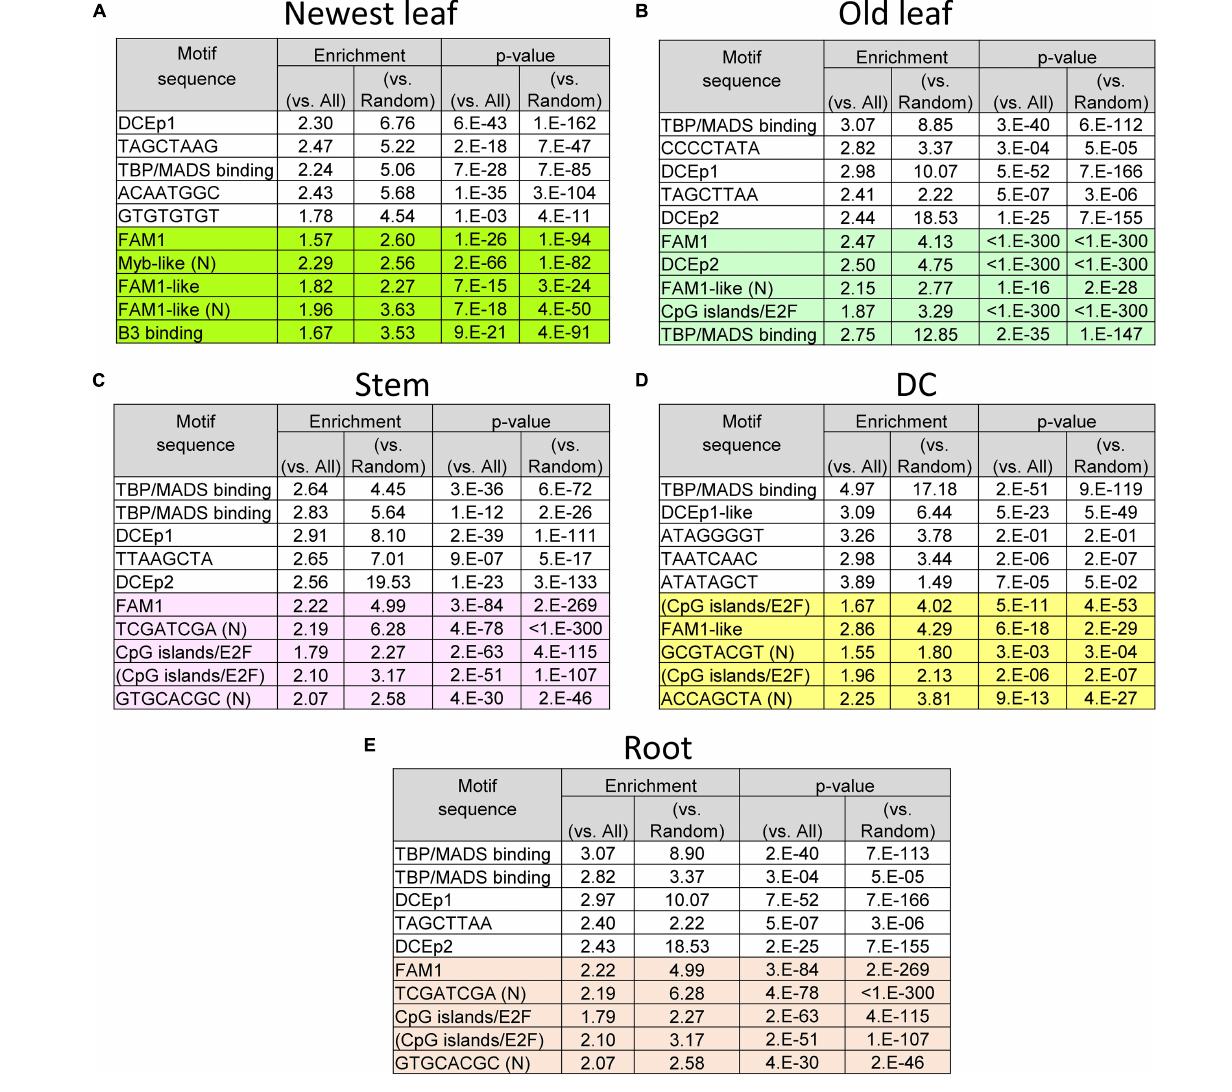
FIGURE 6 | List of extracted CRE candidates from each tissue: (A) Newest leaf, (B) Old leaf, (C) Stem, (D) DC and (E) Root. DC means discrimination center or junction notes between root and shoot. White background cells show CRE candidates from –50 to +150 window, colored background shows CRE candidates from 500 bp upstream of TSS. (N) indicates CRE candidates that were not reported before. CpG islands/E2F (CGCGCGCA) motif has variants CGCGCGCG, CGCGCGTA, and CGCGCGTG. They were annotated as “(CpG islands/E2F).” Enrichment of motifs were calculated as (number in regulon)/(total length of 500 bp upstream or –500 bp to +150 bp sequence of regulon) divided by (number in all genes)/(total length of upstream 500 bp sequence of all genes). P -value was calculated as binominal test using number of motifs found in regulon, number of regulon genes, chance of motif found in all genes. The enrichment and p -value were also calculated using the same size of random sequence instead of sequence of all